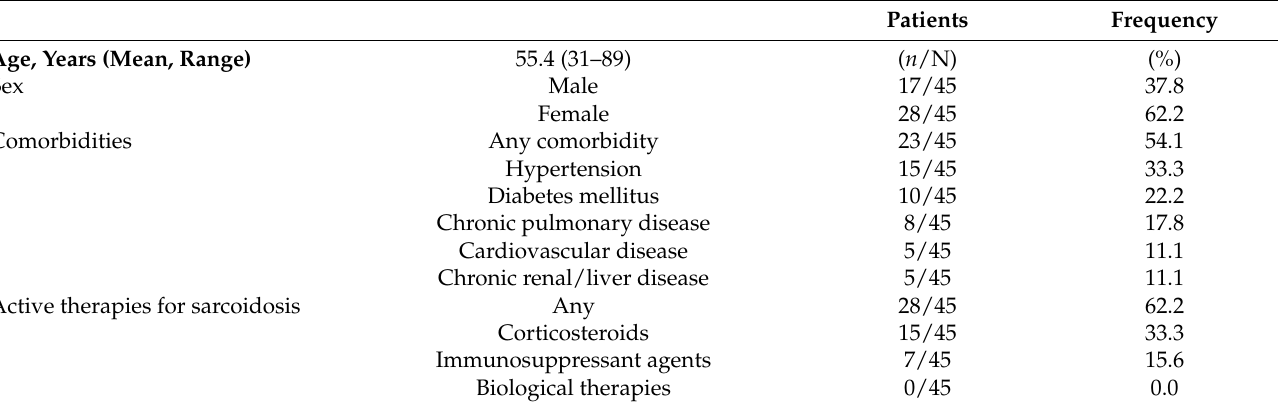
Table 1. Main features of SARS-CoV-2 infection in 45 patients with